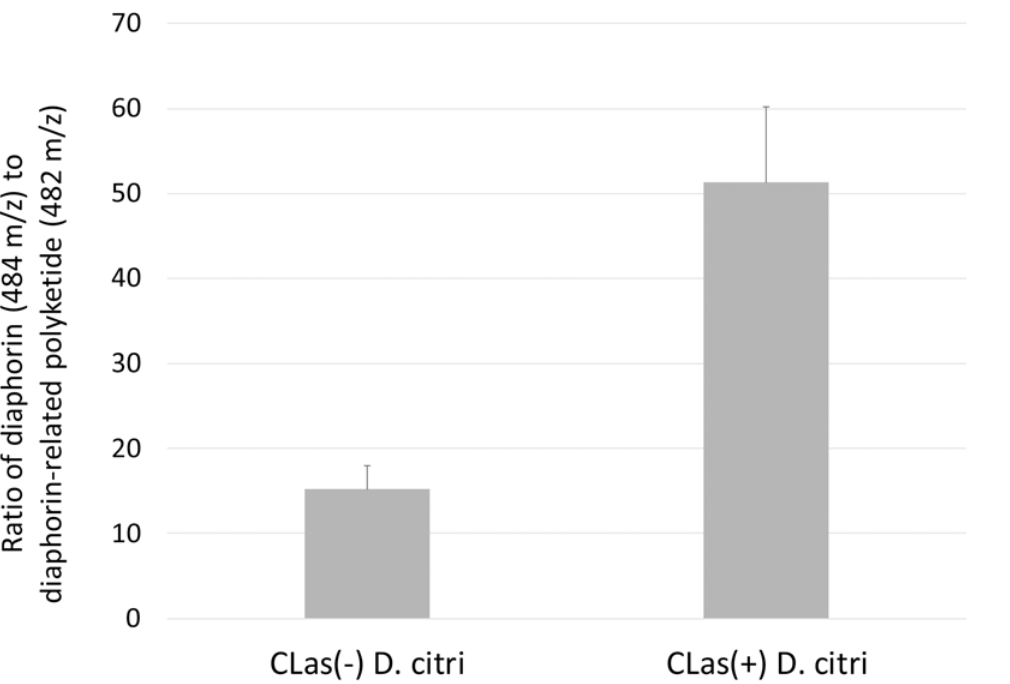
Fig 5. Ratio of integrated peak area from extracted ion chromatograms of 484 m/z and 482 m/z compounds from HPLC-MS analysis of CLas(+)/(-) D . citri methanol extracts. CLas(-): N = 5; CLas(+): N = 6. Mean ratio of 484/482 plus standard error given for CLas(+)/(-) samples.